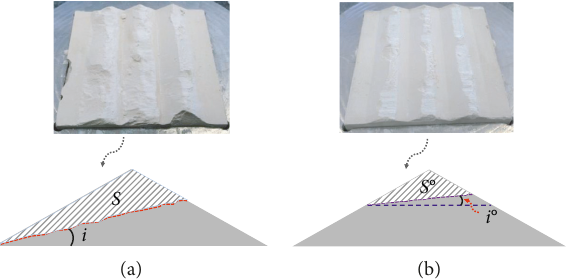
Figure 4: Comparison of dilation and shear-off of closed and opened rock fractures under direct shear. (a) Closed rock fracture; (b) opened rock fracture. S and S o are shear-off area of closed and opened rock fractures under direct shear, respectively, and i and i o are dilation angles at peak shear stress of closed and opened rock fractures, respectively (Li et al. [5]).